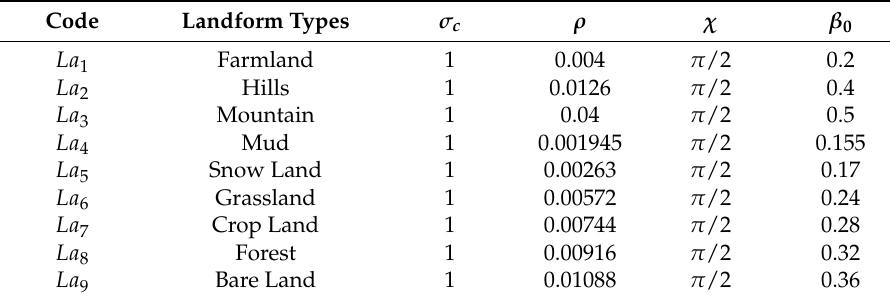
Table 1. Parameter values of landform